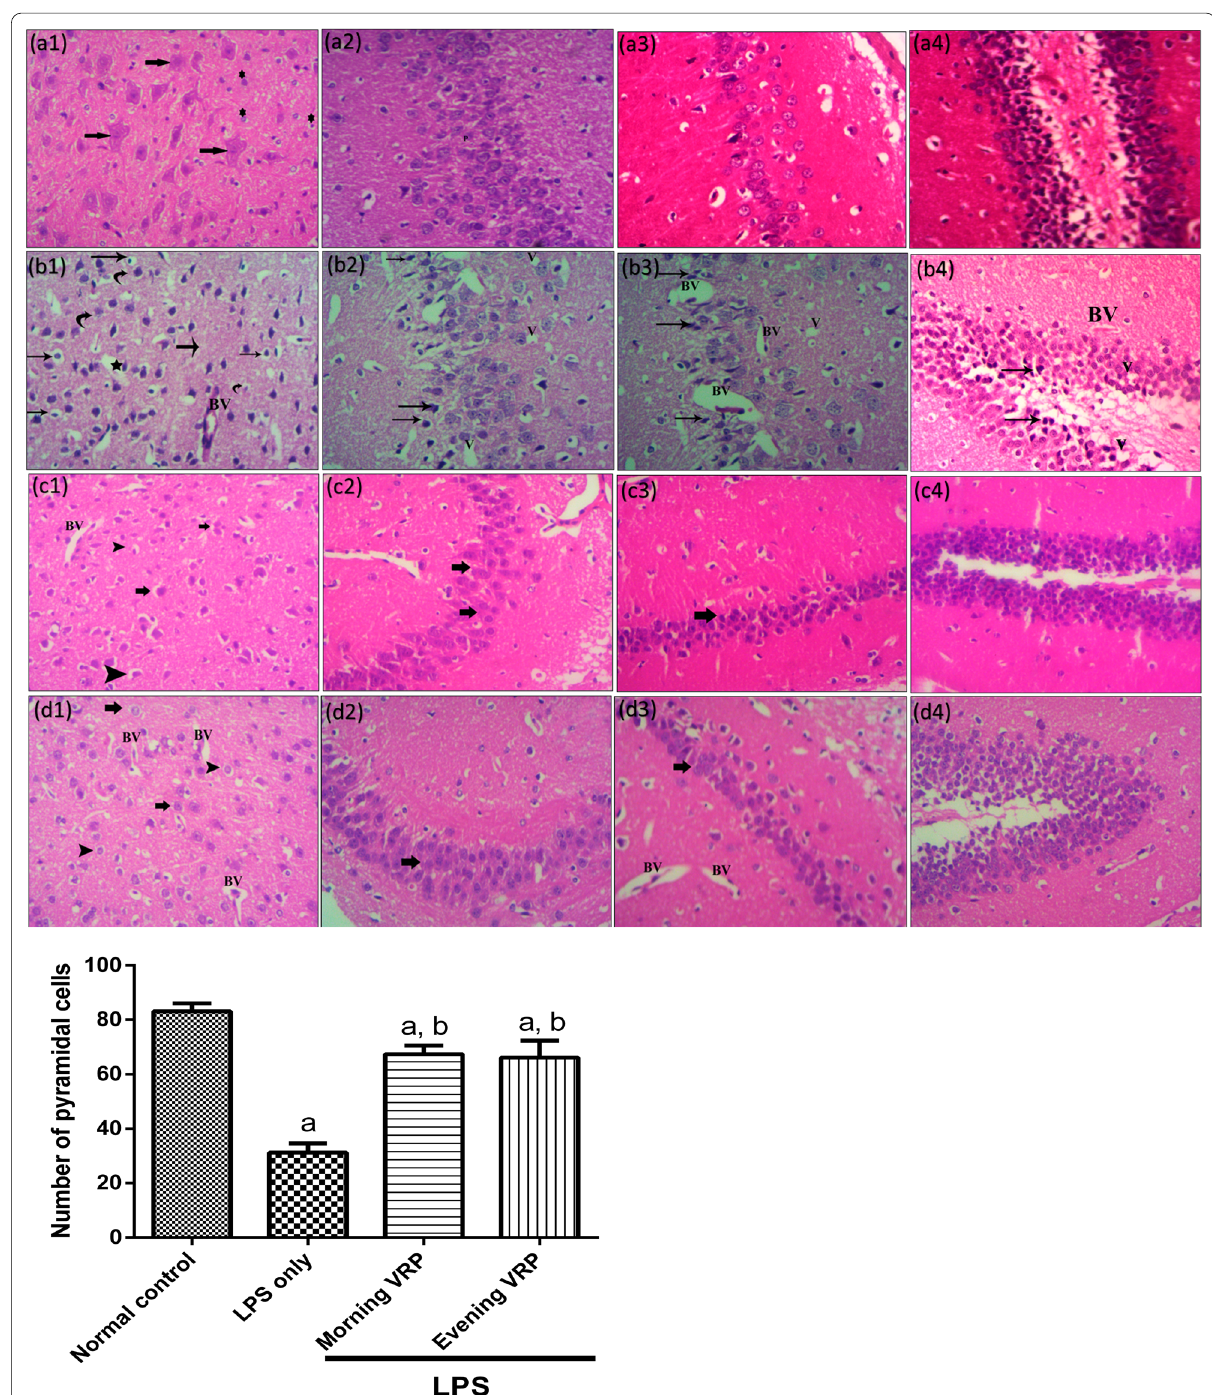
Fig. 2 Effect of VRP on histopathological examination by H&E staining and quantitative measurement of pyramidal cells. a Normal control, b LPS only, c Morning VRP, and d Evening VRP. Four different sectors were examined; 1 : whole brain tissue, 2 : CA1 area, 3 : CA3 area, and 4 : dentate gyrus area. Data are expressed as the mean SD and were analyzed using one-way ANOVA followed by Tukey post hoc test. Values were considered ± significantly different at P < 0.05. a: significant versus normal control and b: significant versus LPS only. LPS: lipopolysaccharides, VRP: